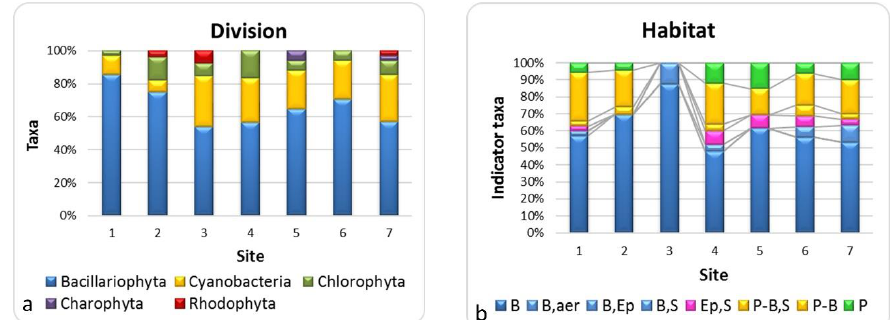
Figure 7. Distribution of the taxonomical content ( a ) and substrate type indicators ( b ) in the studied sites used in Tables 1 and 2 and abbreviation of ecological groups follow those used in Table 3. Ecological and P, planktonic; aer, aerophites.